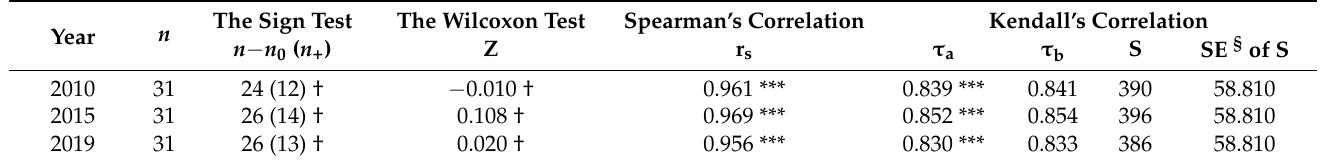
Table 8. Results of the sign test, Wilcoxon test and Spearman and Kendall correlation tests for HALE ranks for the total population and the older subpopulation in 2010, 2015 and